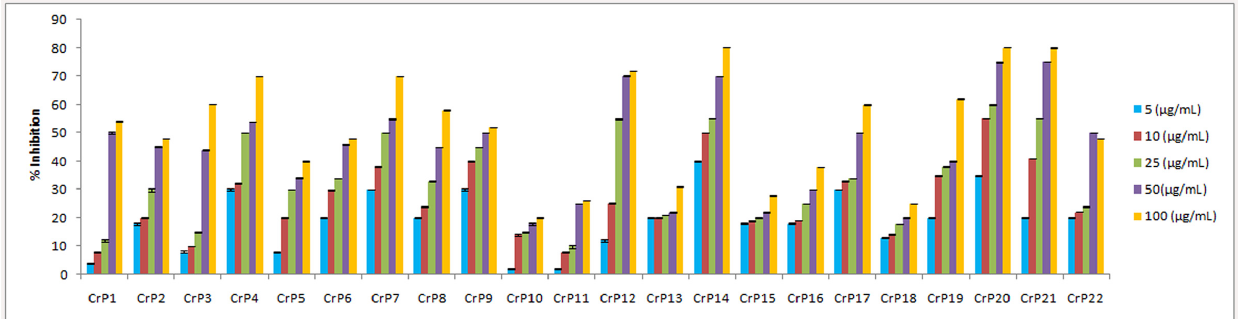
Fig 4. Effects of the ethyl acetate extracts of filtrate on the antiproliferative activity of HeLa cells.